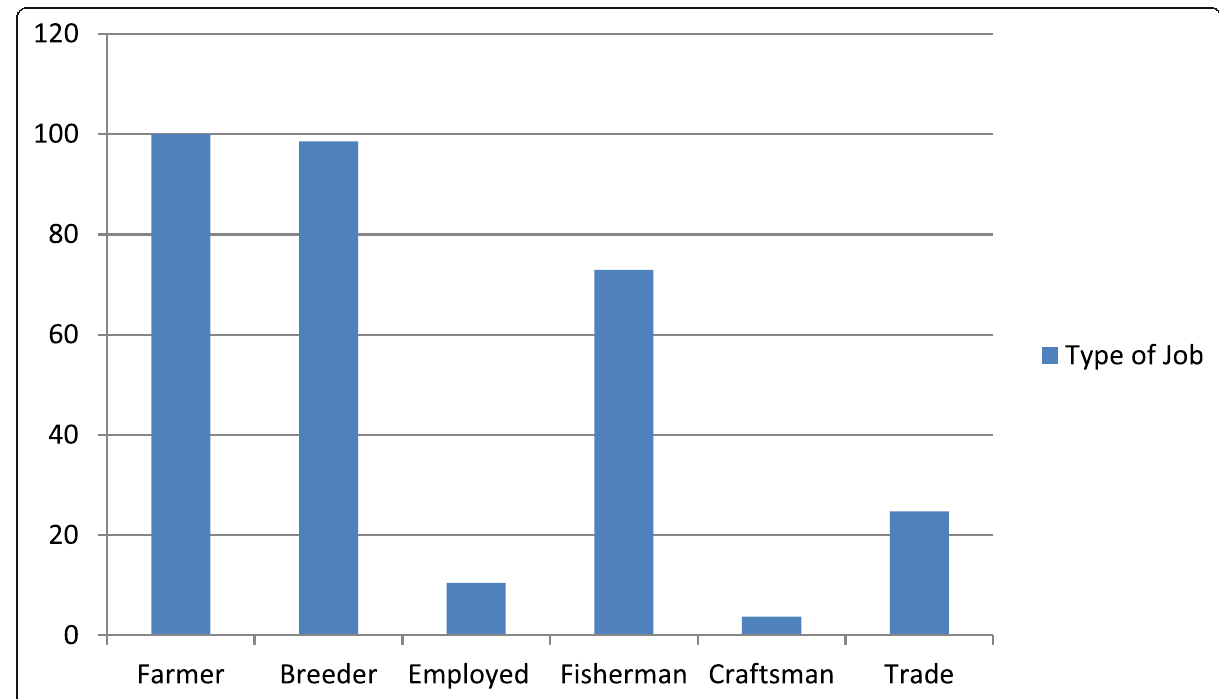
Fig. 2 Percentage of sample households participation in terms of jobs ( N =